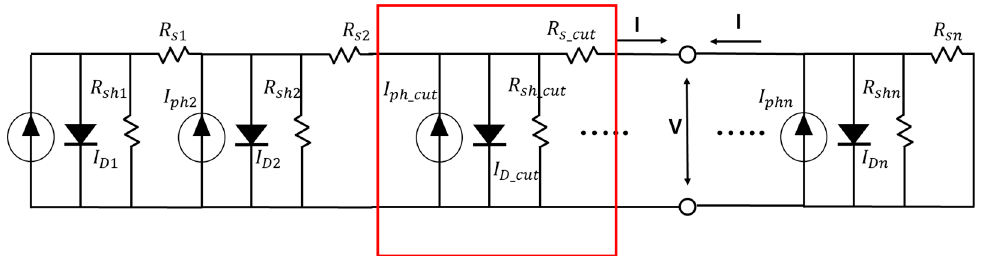
Figure 12. Equivalent circuit of small c-Si solar cells connected in parallel when being cut.